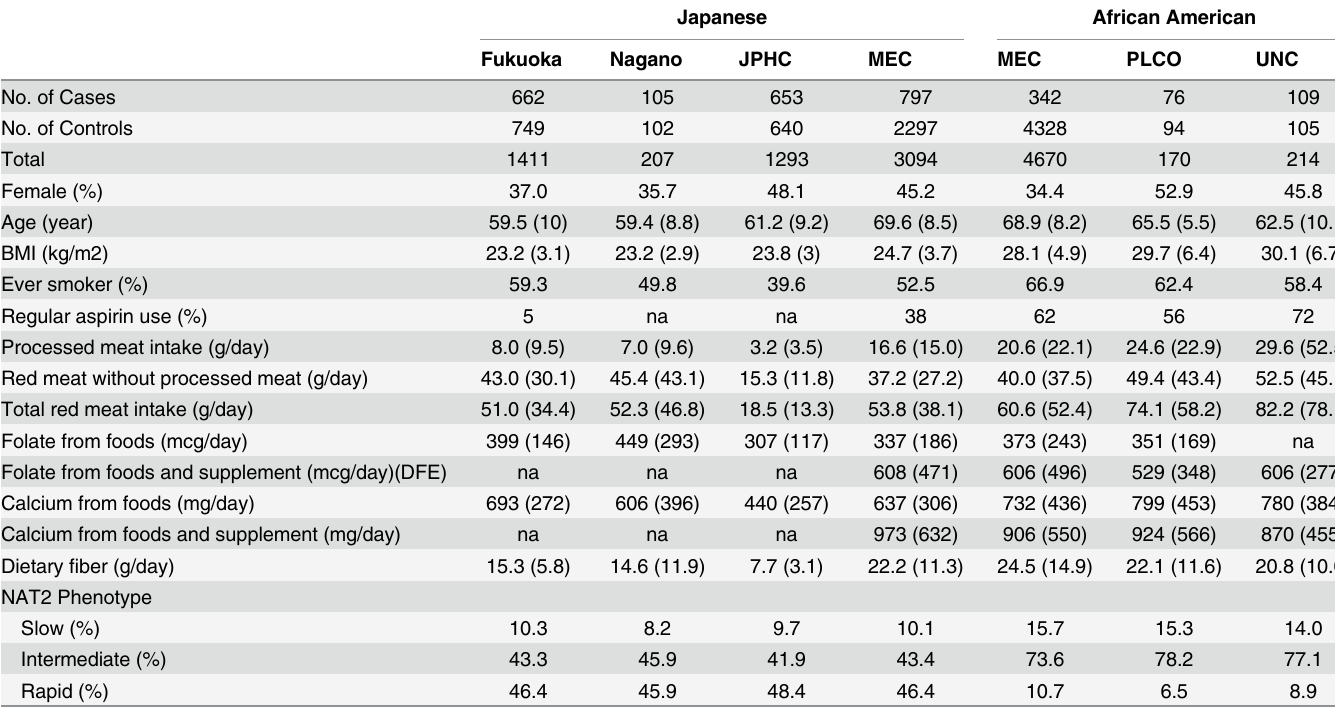
Table 1. Characteristics of study